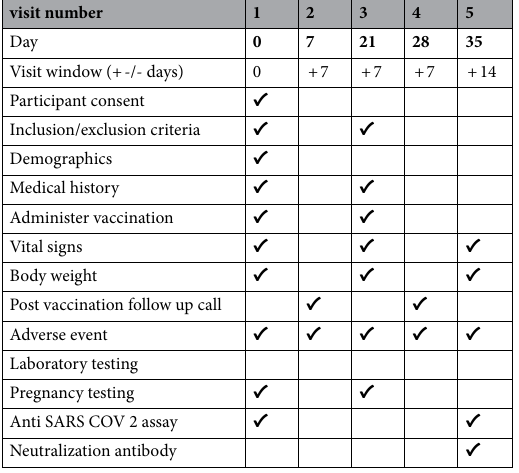
Table 1. Schedule of follow up